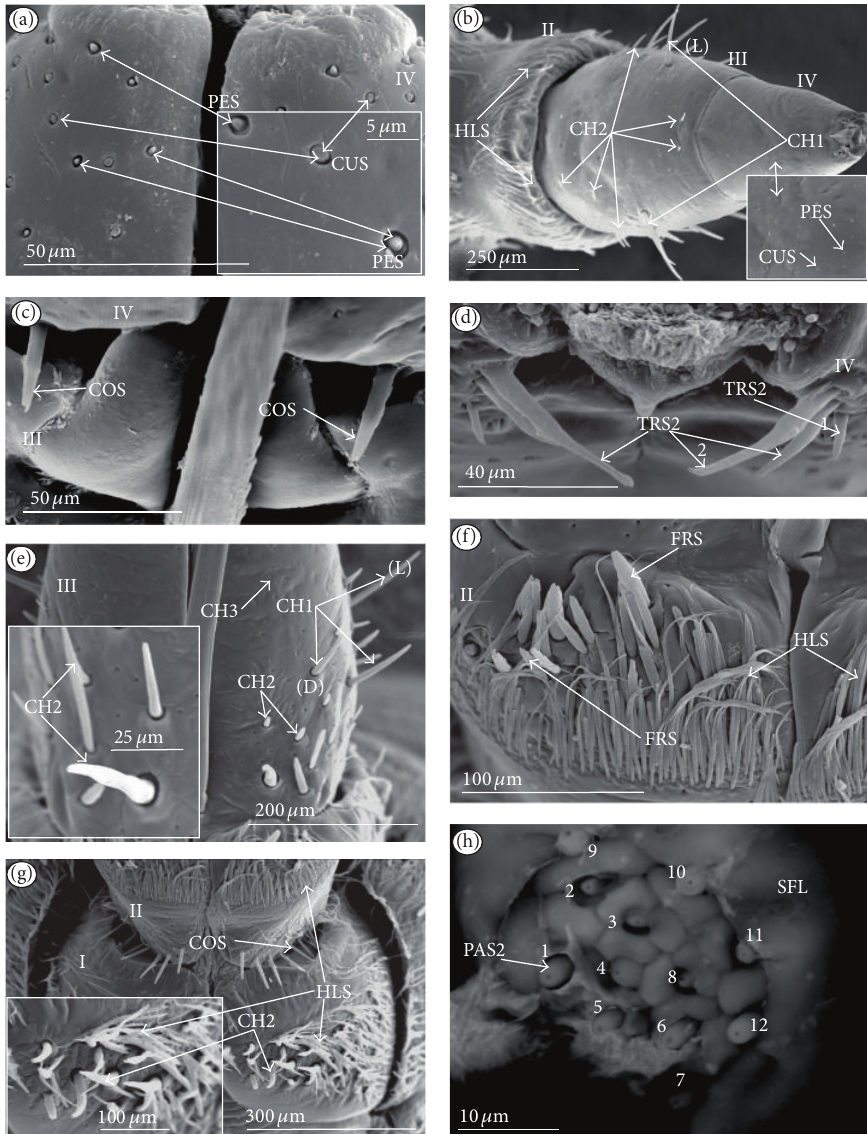
Figure 16: Types and sizes of the sensilla of the Gelastocoridae: Gelastocorinae ( Gelastocoris oculatus ). (a) On the dorsal surface PES are numerous and cover the IV segment of the labium in even rows, and between two rows of pegs there is a row of CUS. (b) CUS and PES are numerous and cover the ventral surface of the IV segment, a few CH1 are situated laterally (L) on the III segment, one pair of CH2 is placed ventrally (V), and a few CH2 are more situated more laterally on the III segment. (c) COS (prioprereceptive sensilla) are situated dorsally on the IV segment near the base of the III segment. (d) TRS2 (three) are situated ventrally near the tip of the labium. (e) CH1, CH2 are less numerous and situated dorsally (D) on the III segment of the labium, and CH3 are numerous and slightly visible. (f) Several FRS are present on the dorsal surface of the II segment, and HLS are very numerous and distributed in bands along the width of segment II. (g) CH2 and HLS are numerous and densely cover the dorsal surface on the labial segment I; COS are situated at the basal edge of the II segment (h) PAS2 (no. 1–13) are on the left SFL, and PIP in not